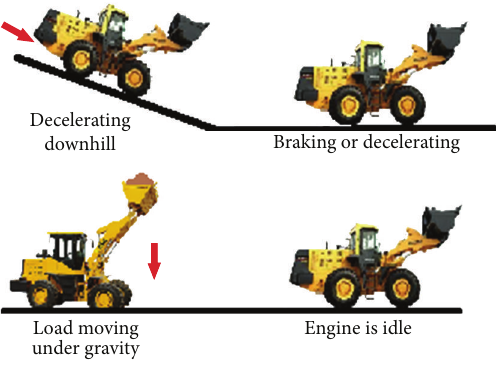
Figure 2: Regeneration